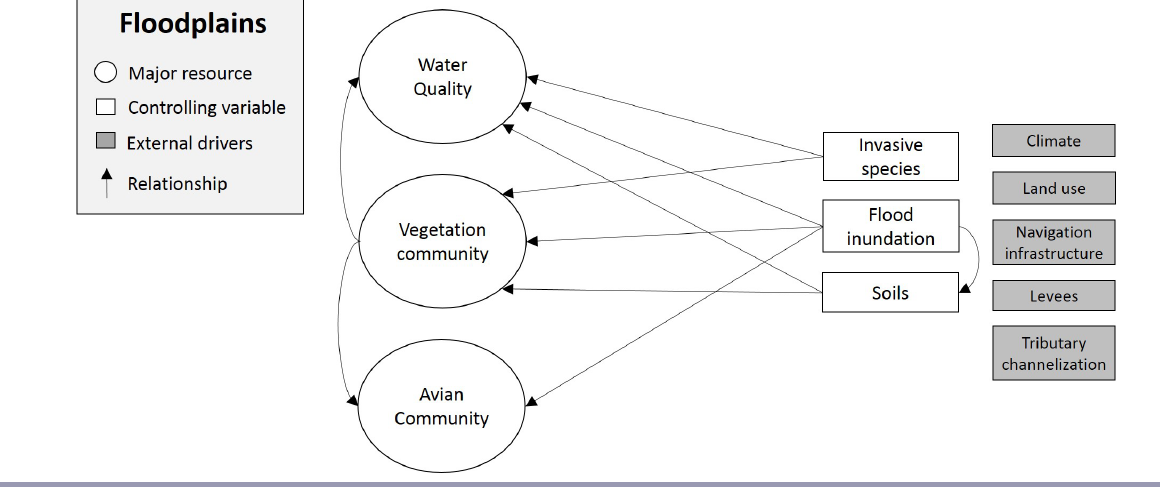
Fig. 7 . The major resources of the floodplain subsystem include water quality, vegetation community, and avian communities, which are known to be strongly influenced by flood inundation regimes, soils, and invasive